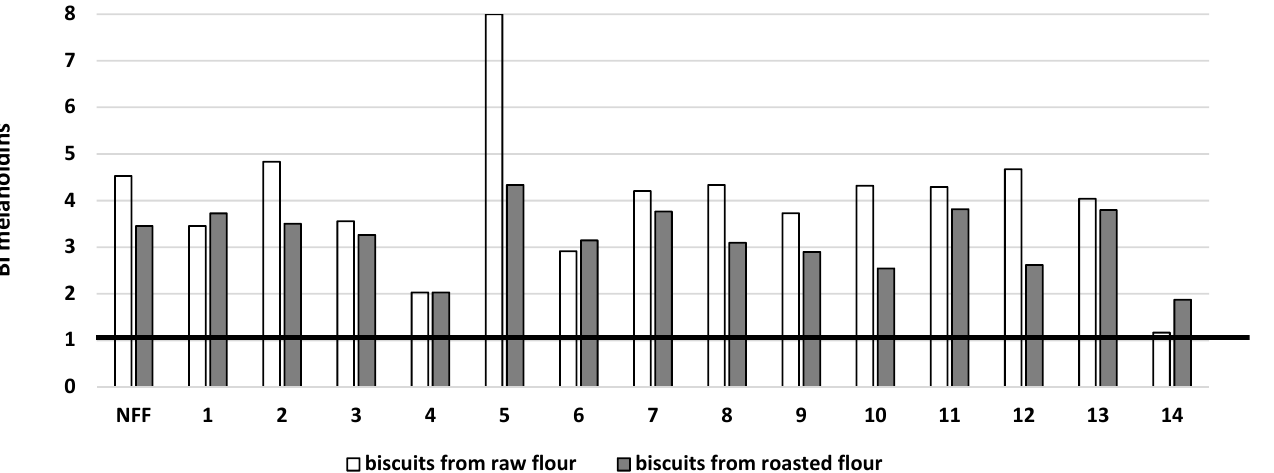
Figure 5. Potential bioaccessibility of melanoidin (BI melanoidin) from buckwheat biscuits baked from raw or roasted buckwheat flour fermented by selected strains of lactic acid bacteria. NFF—nonfermented flour. Flours fermented by: 1 —Lactiplantibacillus plantarum IB; 2— Lactiplantibacillus plantarum W42; 3— Lactobacillus delbrucki subsp. bulgaricus 151; 4— Lacticaseibacillus casei Lcy;